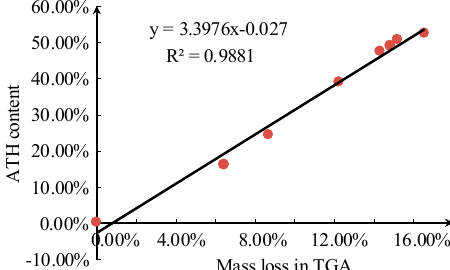
Figure 9. Relationship between actual ATH content and thermal mass loss in the first stage of thermogravimetric analysis.